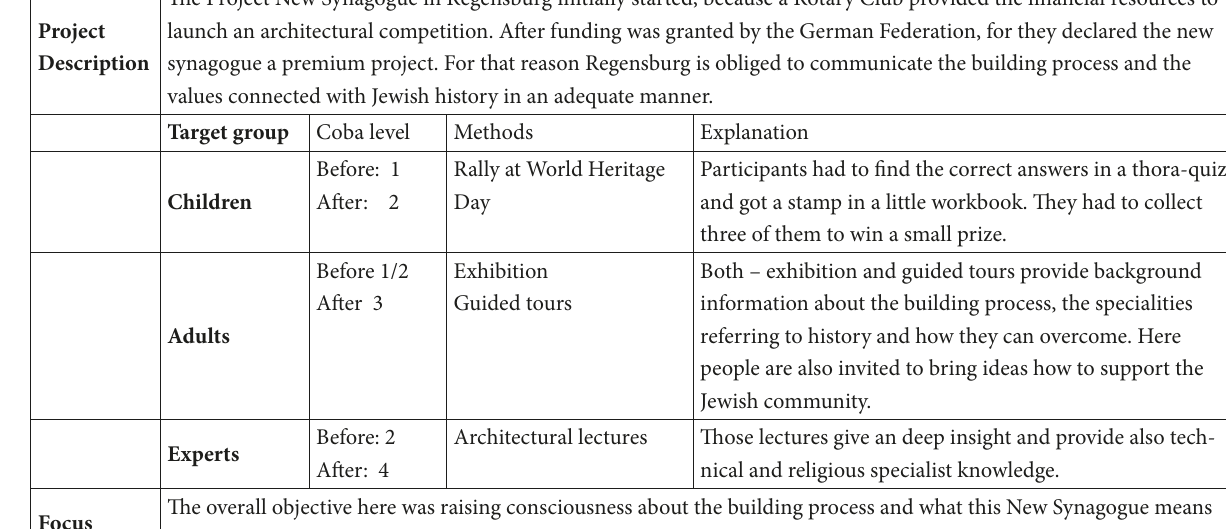
Table 4 Activities for families during World Heritage Days